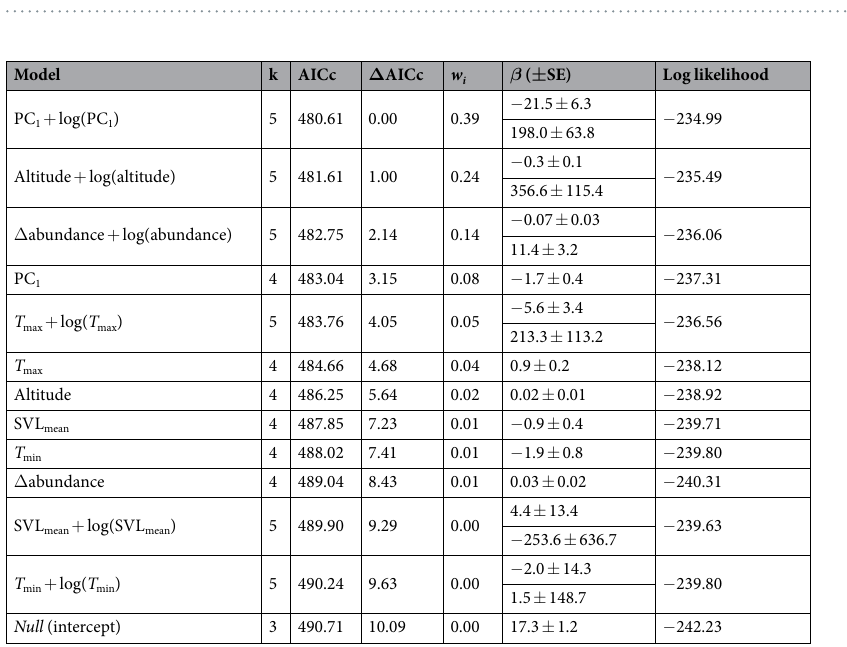
Figure 3. Lack of relationship between telomere length (TL) and lizard body size. TL was not correlated with lizard body size ( P = 0.200) in wild populations (Bas: grey circle, Bel: grey square, Car: white circle, Cha: white diamond, Com: black diamond, Jon: grey diamond, Joc: white square, Laj: black square, Mon: black circle, and Puy: white triangle).